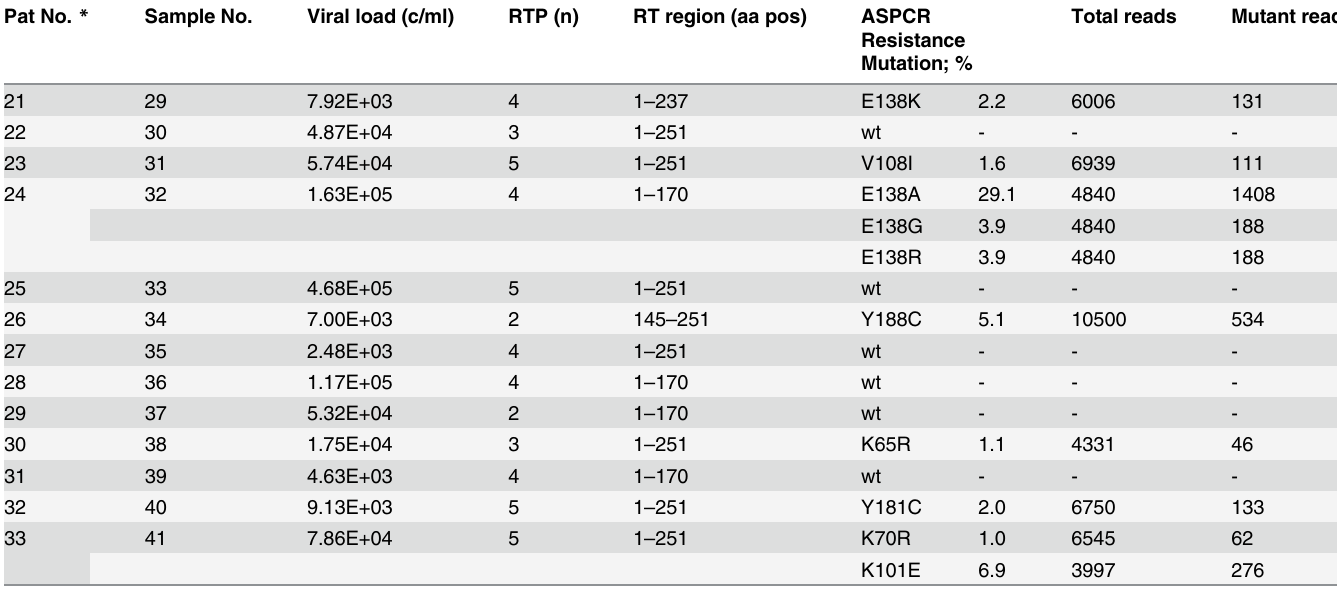
A total of 154/228 (68%) PCR amplicons was generated (median 4 RTPs/sample, IQR 3 – 5). Amplification of RTP4 (10/38) was significantly less successful compared to RTP1 (30/38), RTP2 (27/38), RTP3 (31/38), RTP5 (30/38), and RTP6 (26/38) (RTP4 vs RTP1-3/5-6: all p < 0.001). Successful generation of amplicons significantly correlated with viral loads above 20,000 copies/ml (66/114 vs 88/114: p = 0.003). Amplification success did not depend on the HIV-1 subtype, because 107/156 RTPs were amplified from subtype C-isolates and 47/72 from subtype A1-isolates ( p = 0.650) (Table 2). The failure of RTP generation could be compensated in 20/33 samples by overlapping RTPs (data not shown). Analysis of the entire RT-genomic region (amino acids (aa) 1 – 251 of RT) was therefore possible for 25/38 samples. However, in 13 samples the RT-region was not fully covered: the 3'-RT-region downstream of the aa position 170 or 237 was missing in ten samples (no compensation for RTP4 and RTP6 or for RTP6 only, respectively) and the 5'-RT-region upstream of the aa position 145 was missing in three samples (no compensation of RTP1-4 or RTP 4 – 5, respectively). resistance mutations were detected with coverages ranging from 845 to 13,252. In total, 45 drug-selected resistant variants were identified by amplicon-based UDS in 25 samples. Nine resistant variants with the AZT-selected mutations K70R and/or T215I were identified in eight samples at frequencies of 1.0% to 10.0%. Twenty-eight NVP-selected mutations (V90I, K101E, in 19 samples at levels of 1.1% to 99.1%. Seven 3TC-selected mutations (K65R or M184I) were present in six samples at frequencies of 1.0% to 6.1% (Table 2). From a total of 45 resistance mutations, 18 (40%) were present at ASPCR key resistance positions, while 27 (60%)